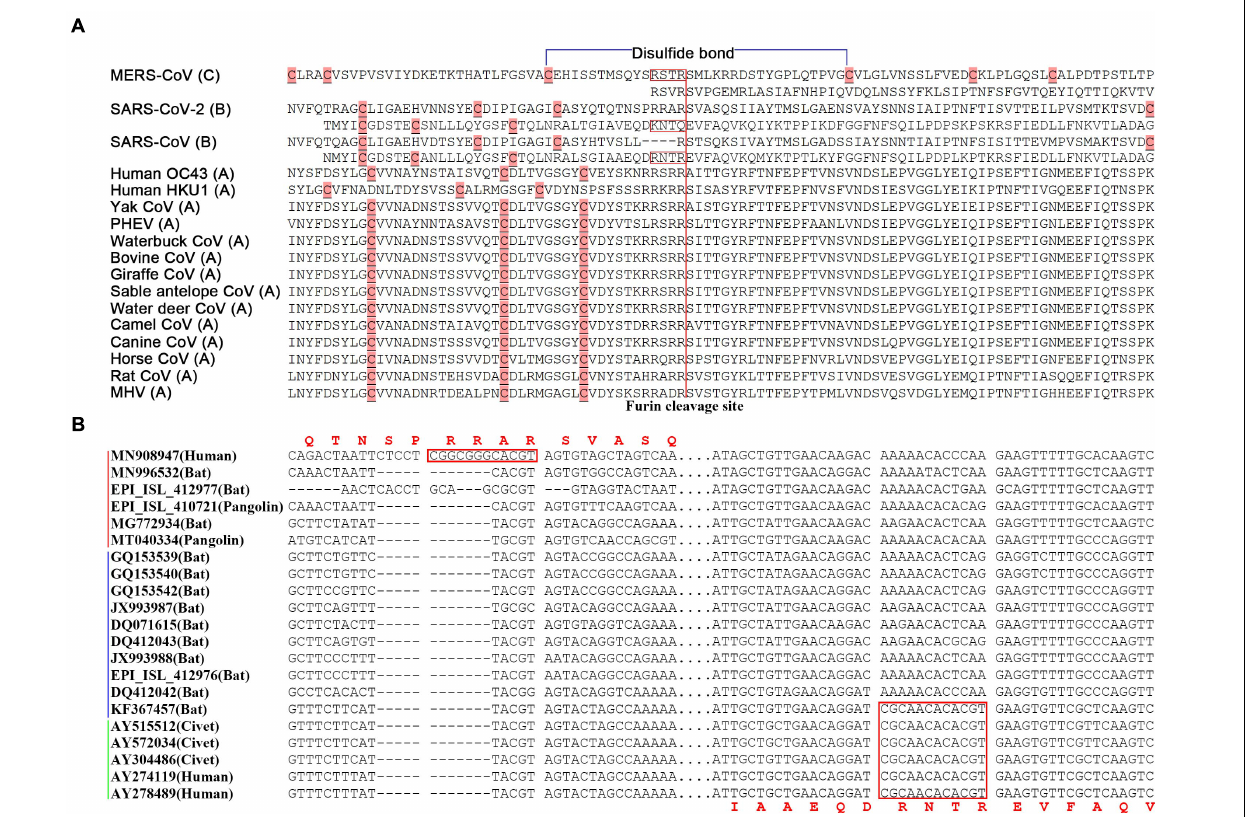
Frontiers in Microbiology |